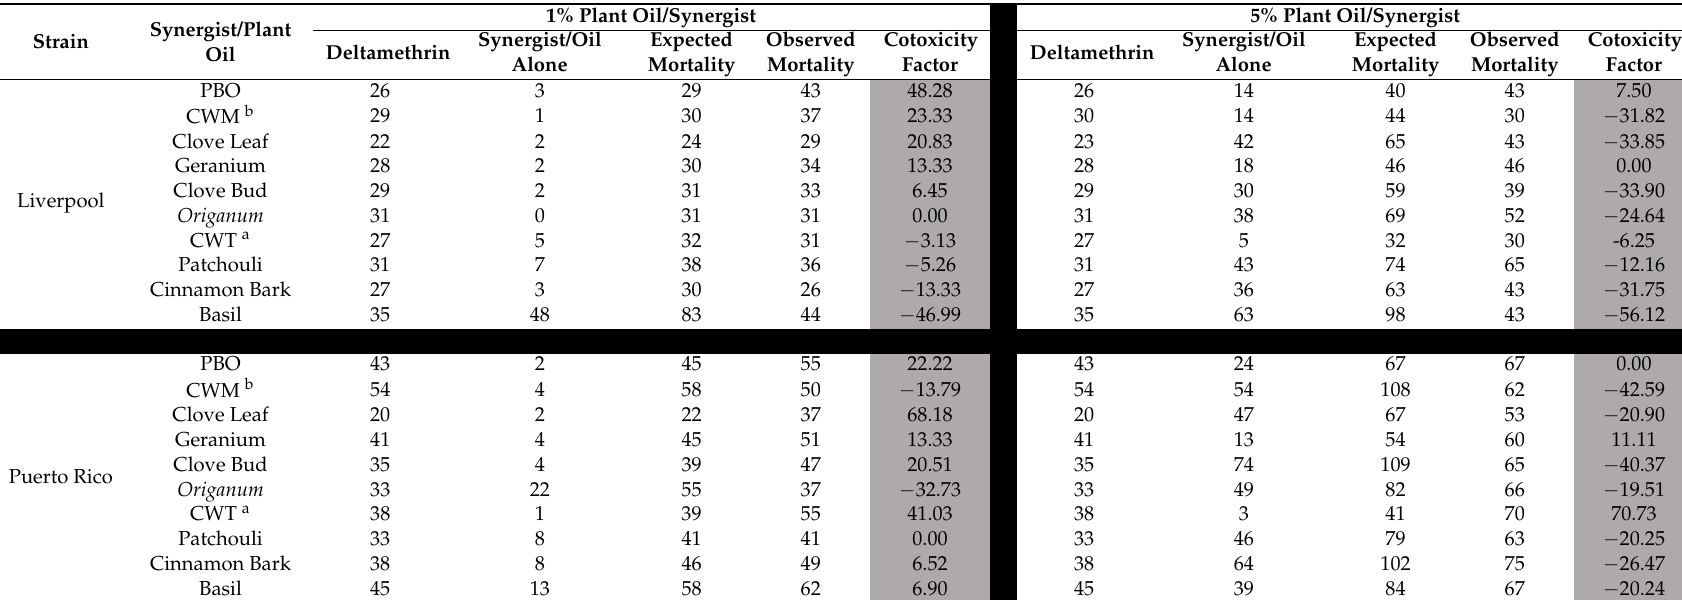
Table 3. Synergism caused by plant essential oils in combination with deltamethrin against Ae. aegypti